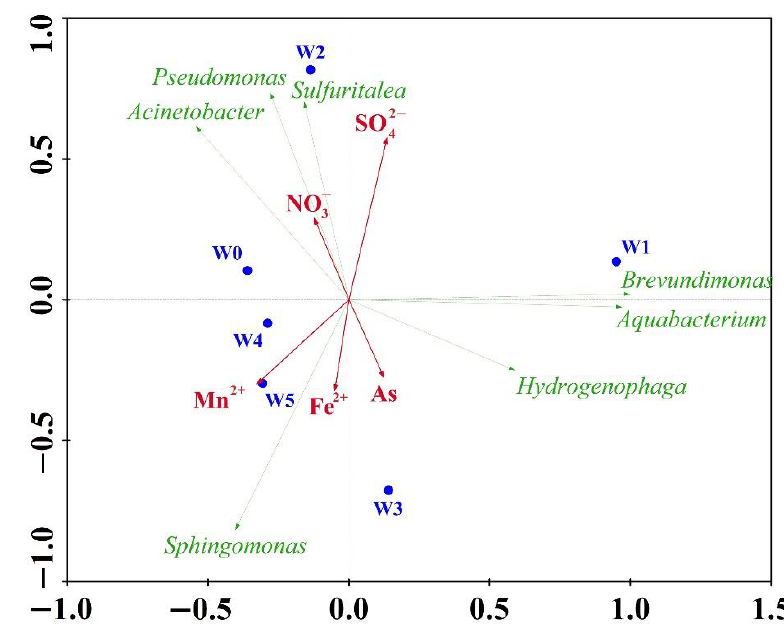
Figure 7. Redundancy analysis in the genus-level.